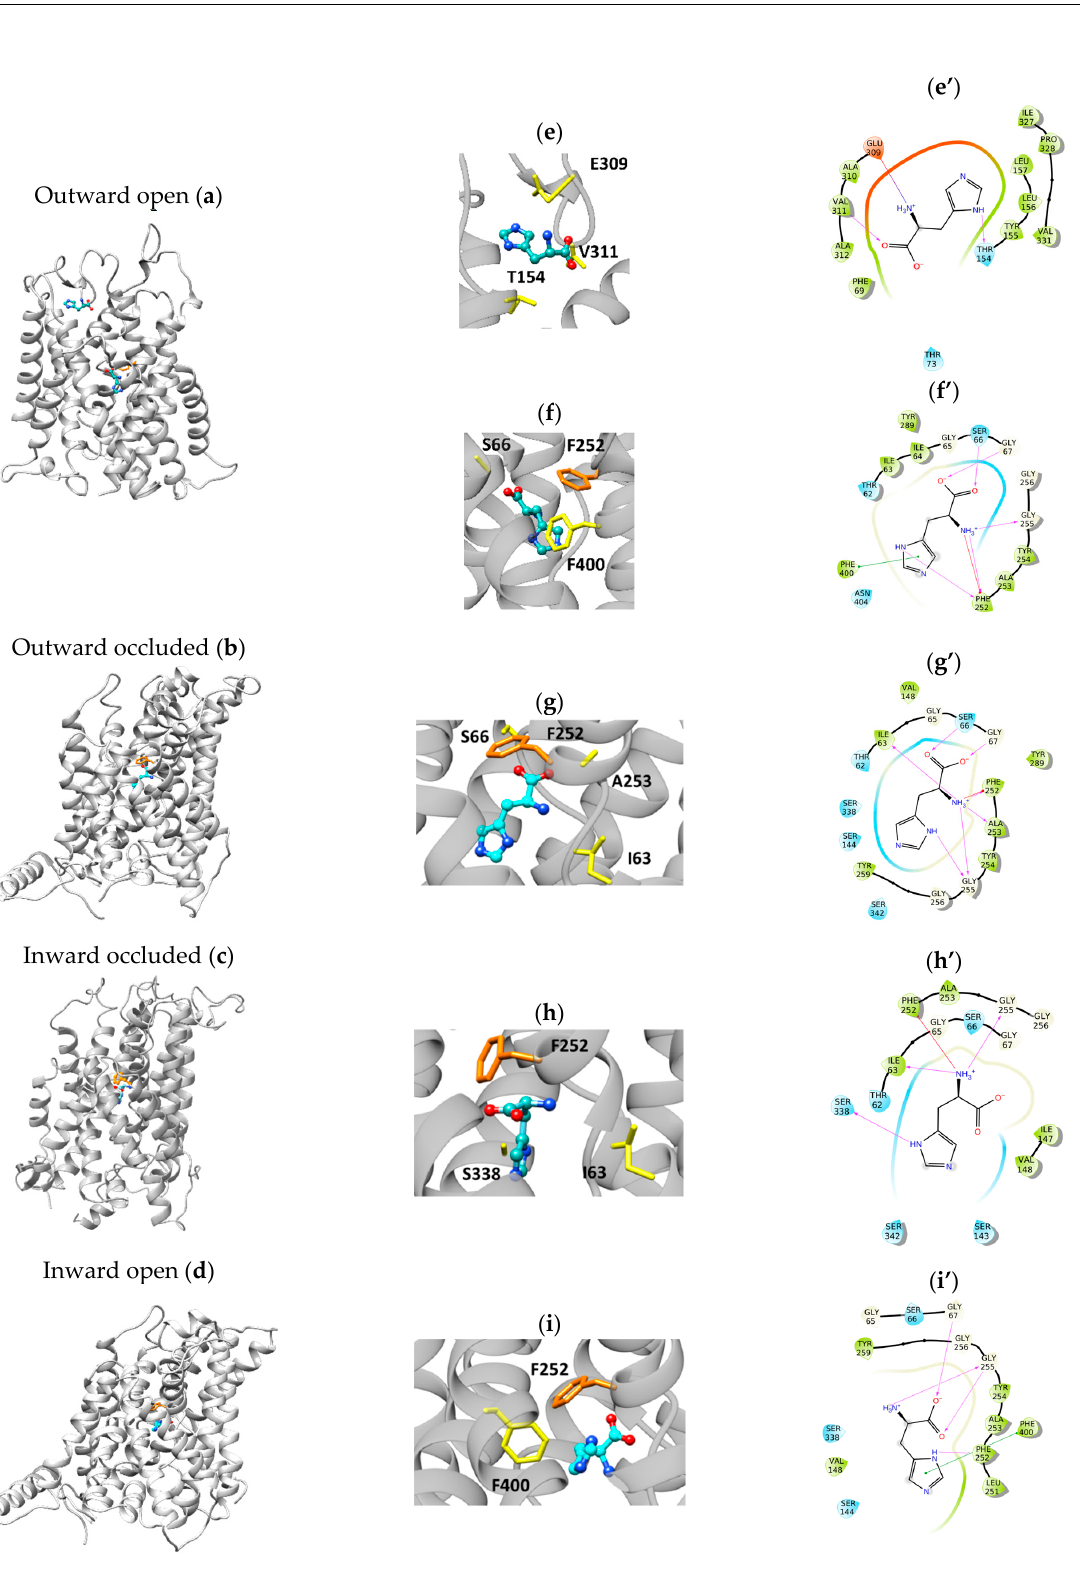
Figure 5. Docking analysis showing the interaction of the substrate with LAT1 in the different conformations. ( a – d ), histidine (in cyan), and the F252 (in orange) are shown. ( e – i ), zoom of the binding site regions in which residues are involved in the interactions (in yellow), among which F252 (in orange), are shown. ( e’ – i’ ), the 2D view from Maestro of the ligand interaction with the residues corresponding to the 3D ( e – i